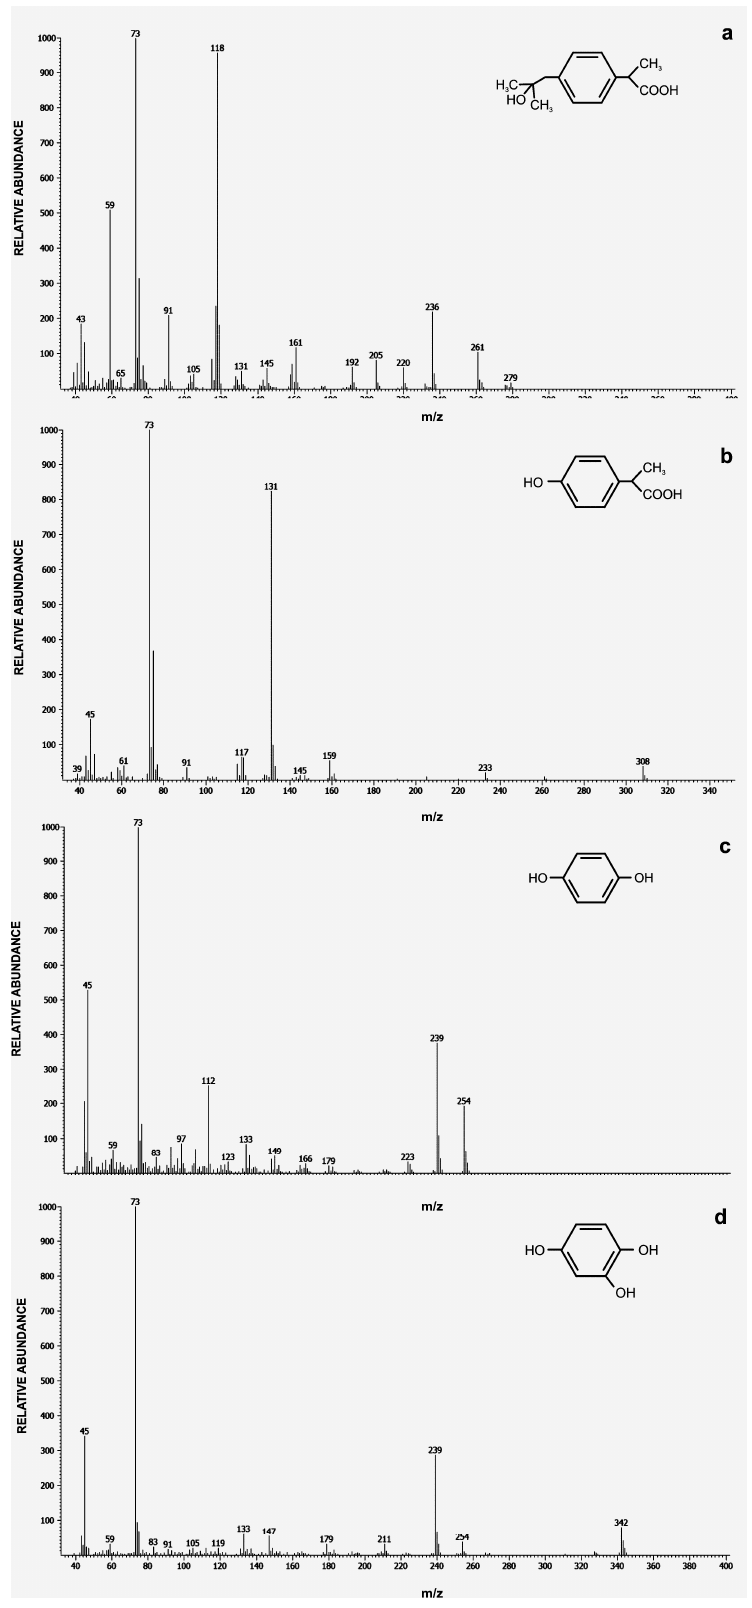
Figure 6. Spectra of putative metabolites identified via GC/MS analyses: 2-hydroxyibuprofen ( a ); 2-(4-hydroxyphenyl-) propionic acid ( b ); 1,4-hydroquinone ( c ); and 2-hydroxy-1,4-quinol ( d ).